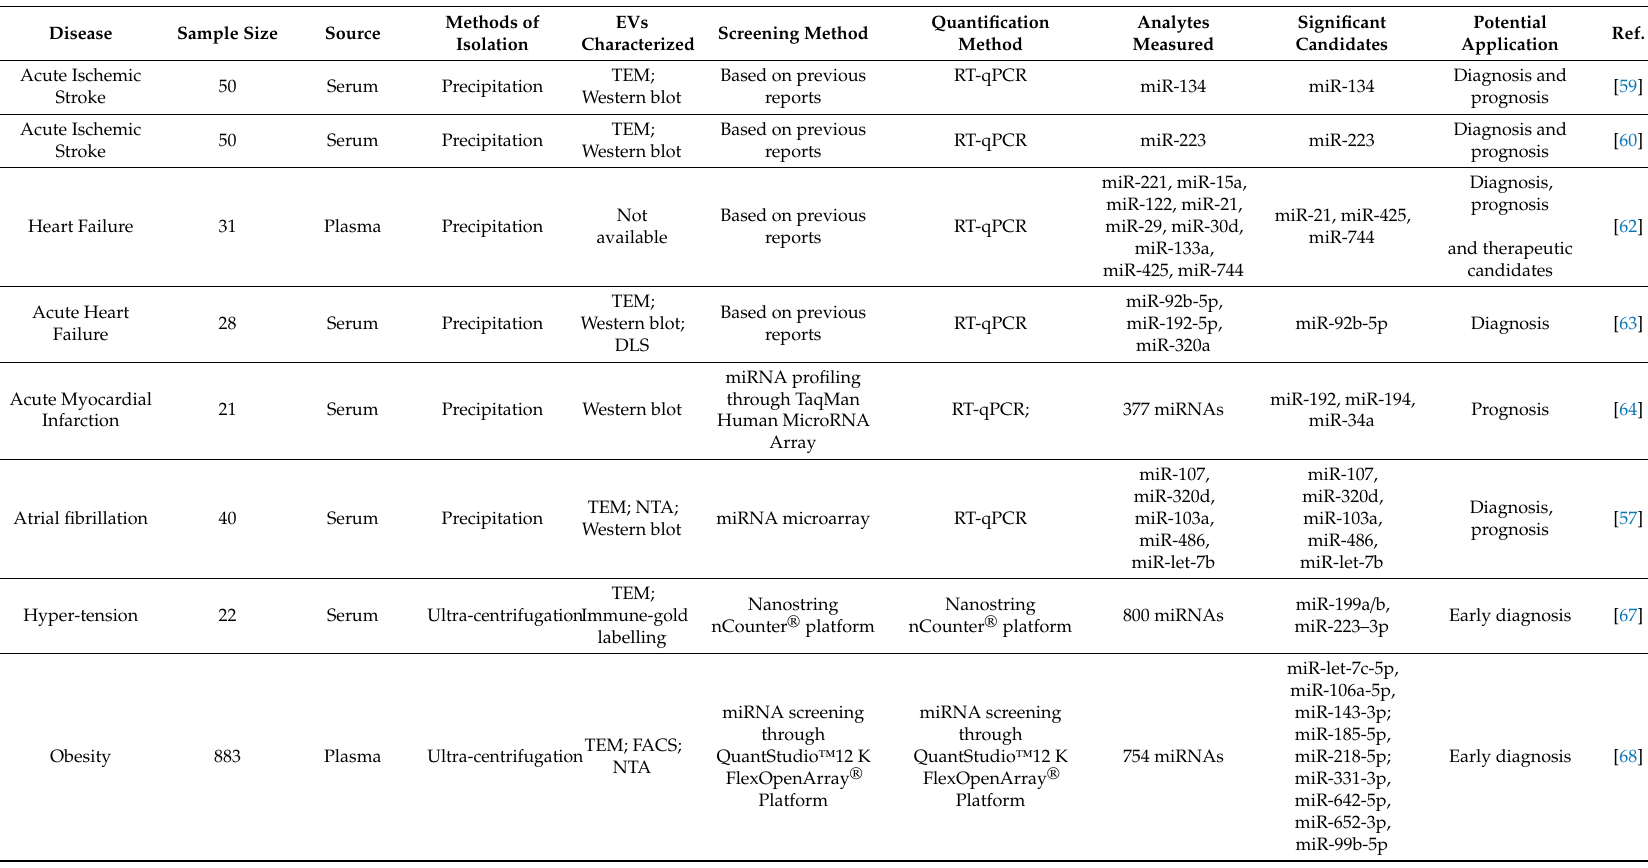
Table 1. Summary of extracellular vesicle contents as diagnostic or prognostic biomarkers in